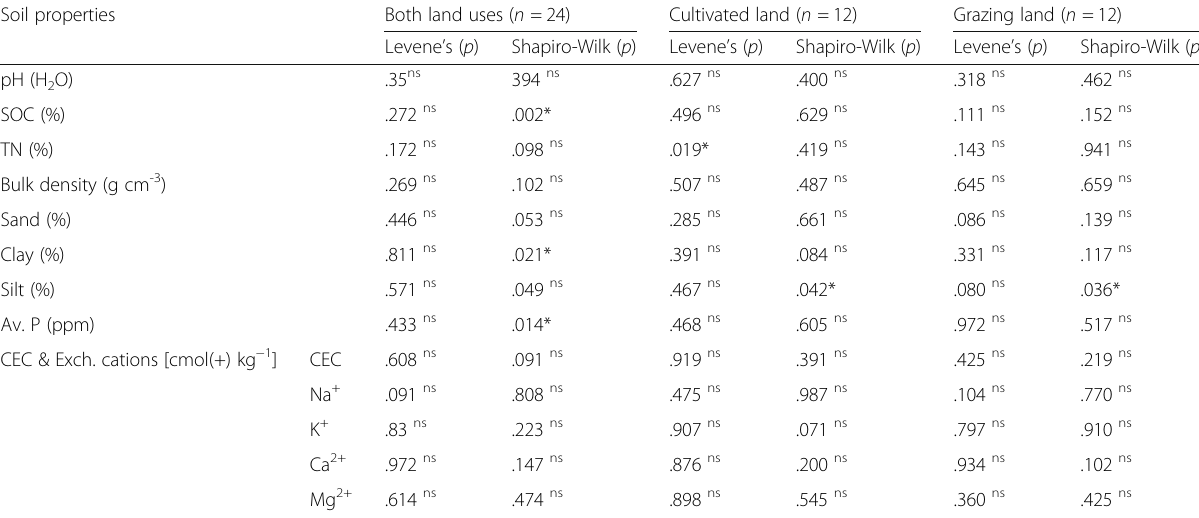
Table 1 Test of normality and homogeneity of variance for soil physical and chemical properties in both land uses and per land use